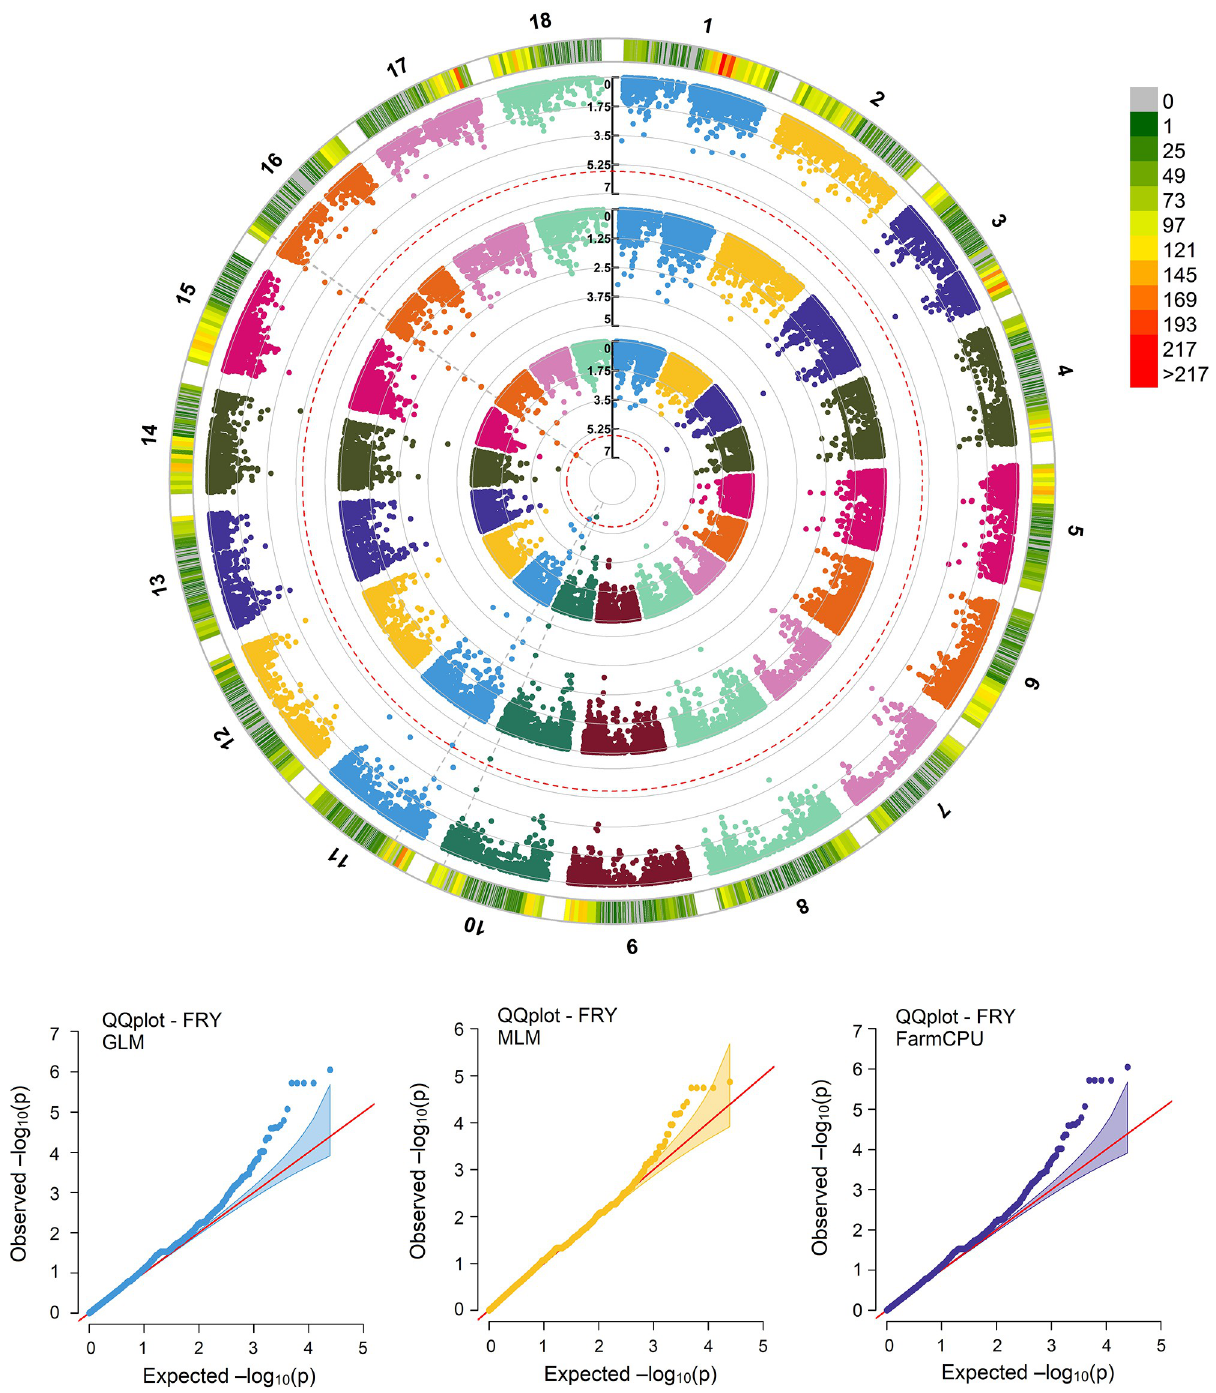
Fig 6. Circular Manhattan plot indicating single nucleotide polymorphisms associated with fresh root yield according to the FarmCPU (outer circle), MLM (middle circle), and GLM (inner circle) models. The dotted red line indicates the threshold for significant association, after applying the Bonferroni correction (p < 0.05). The quantile-quantile (QQ) plots are of expected versus observed significance levels for each GWAS model. The red diagonal lines indicate the null hypothesis, where the observed and expected P-values would be situated if there were no associations. The shaded area indicates a 95% confidence